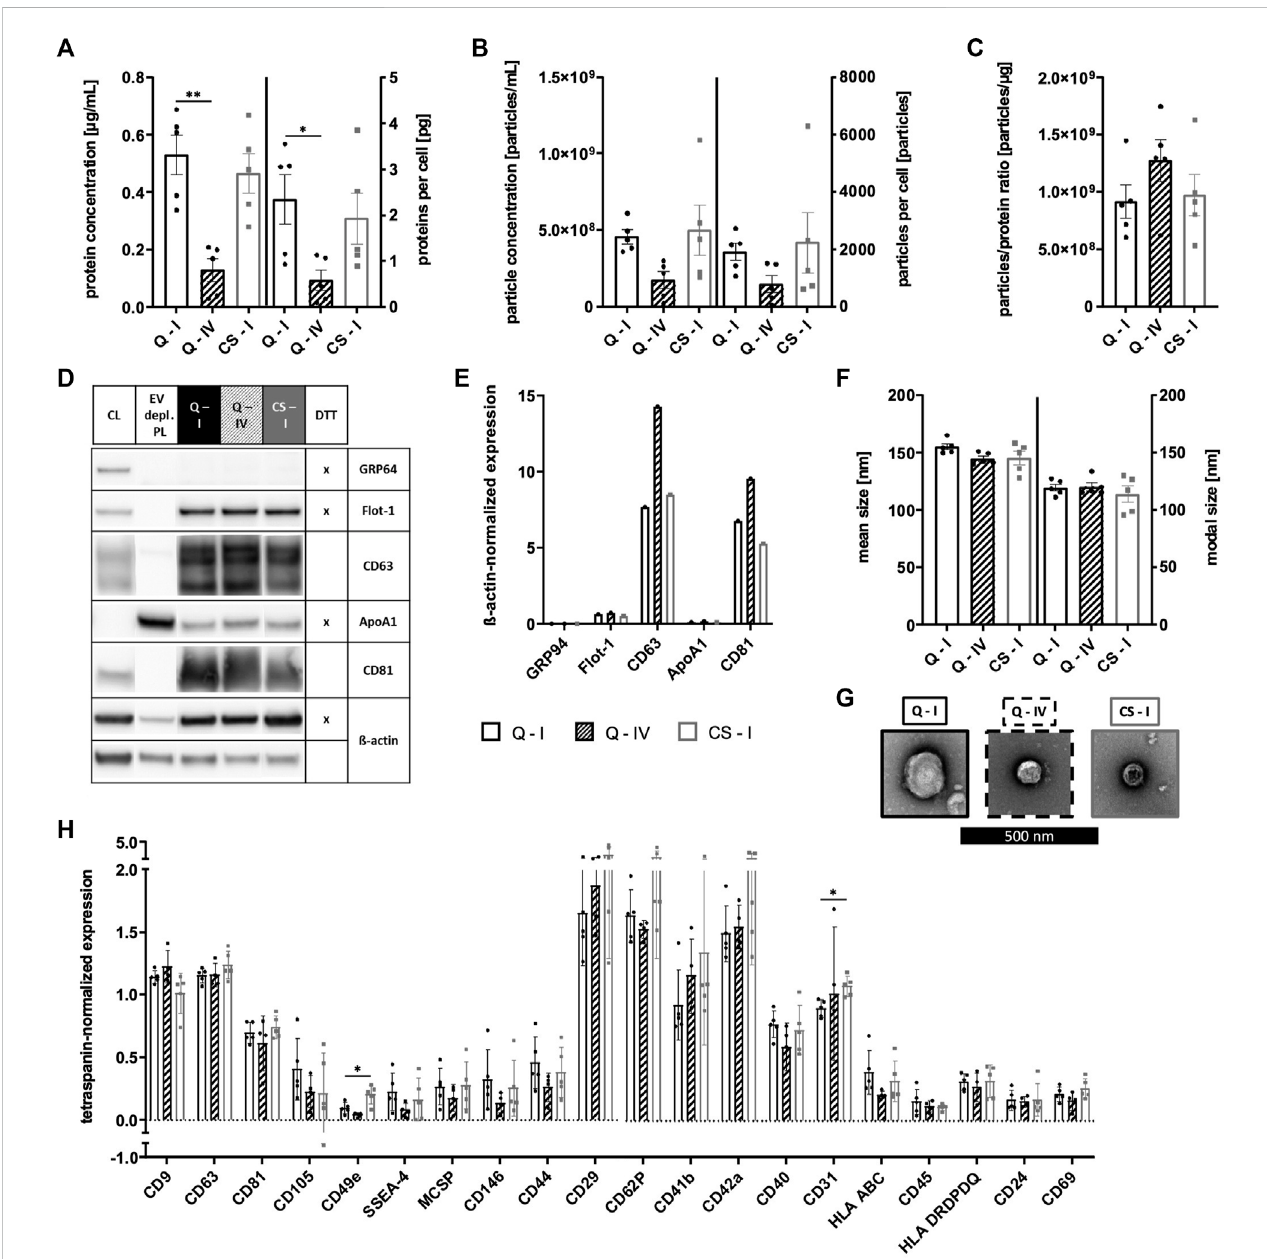
Quanti fi cationandcharacterizationofsEVsfromQuantum-andCellSTACK-basedMSCexpansion.sEVswerecollectedinCMforQuantum-(Q)and CellSTACK-based expansion (CS), respectively. sEVs were isolated from CM by method I for both expansion systems (Q — I; black and CS — I; gray) in addition to method IV for Quantum-derived CM (Q — IV; black with stripes). (A) Protein concentration of sEVs and proteins per cell were quanti fi ed by BCA assay. (B) Particle concentration and particles per cell were analyzed by NTA. (C) Particles to protein ratio was calculated for information on purity of isolated sEVs. (D) Western blotting was performed in order to investigate the expression of proteins GRP94, Flot-1, CD63, ApoA1, and CD81. MSC cell lysate (CL) and EV depl. PL served as controls for primary antibodies, and ß-actin was used as loading control. Reducing conditions for indicated proteins were obtained by the addition of dithiothreitol (DTT). (E) Chemiluminescent signal intensities were quanti fi ed and normalized on ß-actin intensities, resulting in ß-actin-normalized expression of proteins. (F) Mean and modal size of sEVs was determined by NTA. (G) sEVs were visualized by negative contrast staining using TEM with 60,000 times magni fi cation. The black scale bar represents 500 nm. (H) The expression of several surface antigens by sEVs was analyzed using MACSPlex technology. sEVs were bound by capture beads with epitopes against each analyzed surface antigen and detected indirectly by an APC-coupled detection reagent directed against the tetraspanins CD9, CD63, and CD81. Due to the indirect detection, fl uorescence intensity of each surface antigen was normalized on mean fl uorescence intensity of CD9, CD63, and CD81, resulting in tetraspanin-normalized expression.RepresentativeimagesaredepictedforwesternblottingandTEM.Dataarepresentedasmean±SD,andN ≥ 4independentexperimentswere performed for BCA assay, NTA and MACSPlex analyses. Statistically signi fi cant differences are depicted as follows: *: p < 0.05, **: p <